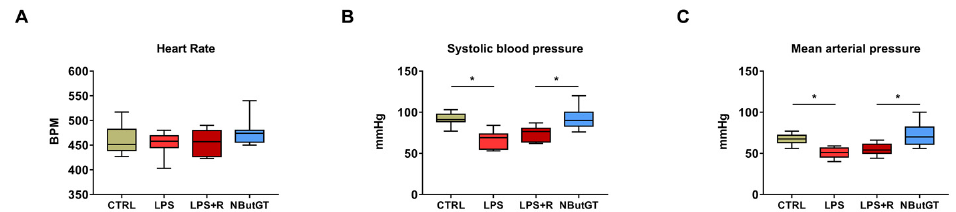
Figure 2. Impact of endotoxemic shock and O-GlcNAc stimulation on heart rate, systolic blood pressure and mean arterial pressure in young rats. To study the impact of endotoxemic shock and treatments, measures of heart rate ( A ), systolic blood pressure ( B ) and mean arterial pressure ( C ) were performed. Statistical significance was assessed by Kruskal–Wallis test with uncorrected Dunn’s post-test (*: p < 0.05). CTRL: control group, LPS: i.v. injection of LPS (20 mg/kg), LPS+R: subcutaneous administration of 10 mL/kg of NaCl 0.9%, NButGT: resuscitation supplemented with NButGT (10 mg/kg). Results are expressed as mean ± SEM. n =